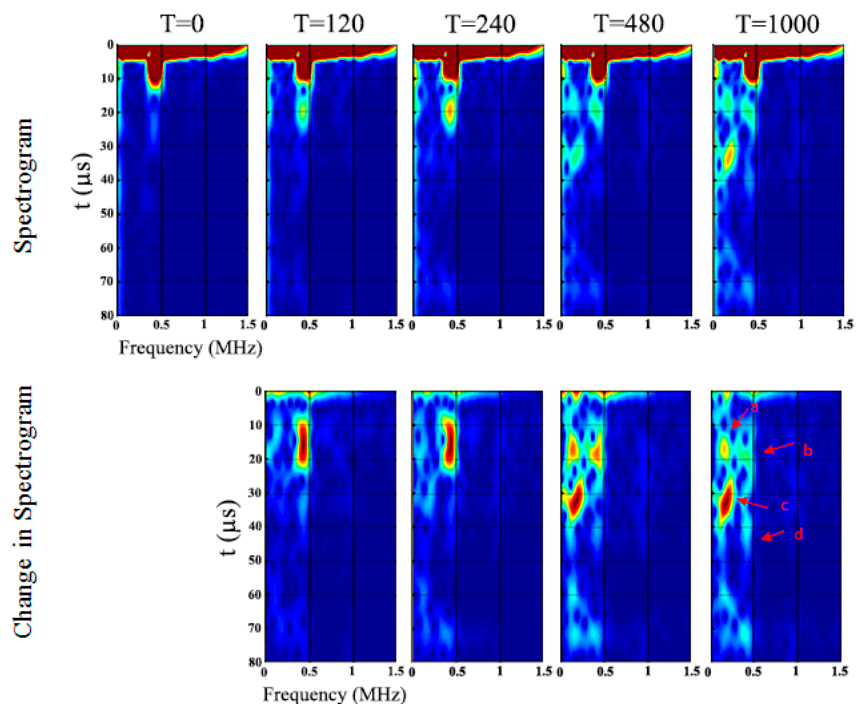
Figure 10. Oval specimen (Far): Spectrogram and changes in spectrogram for each cure time relative to the baseline.